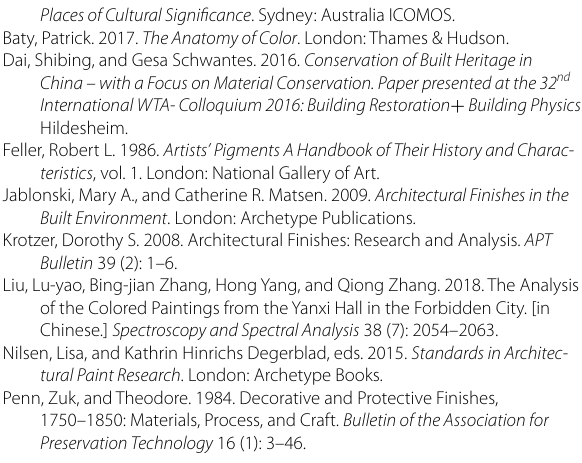
Fig. 8: Photo by Professor Zong Tang, College of Architecture and Urban Plan- ning, Tongji University. For Figs. 2 and 4: The permission for reproduction of the historic images from the HSBC Archives were